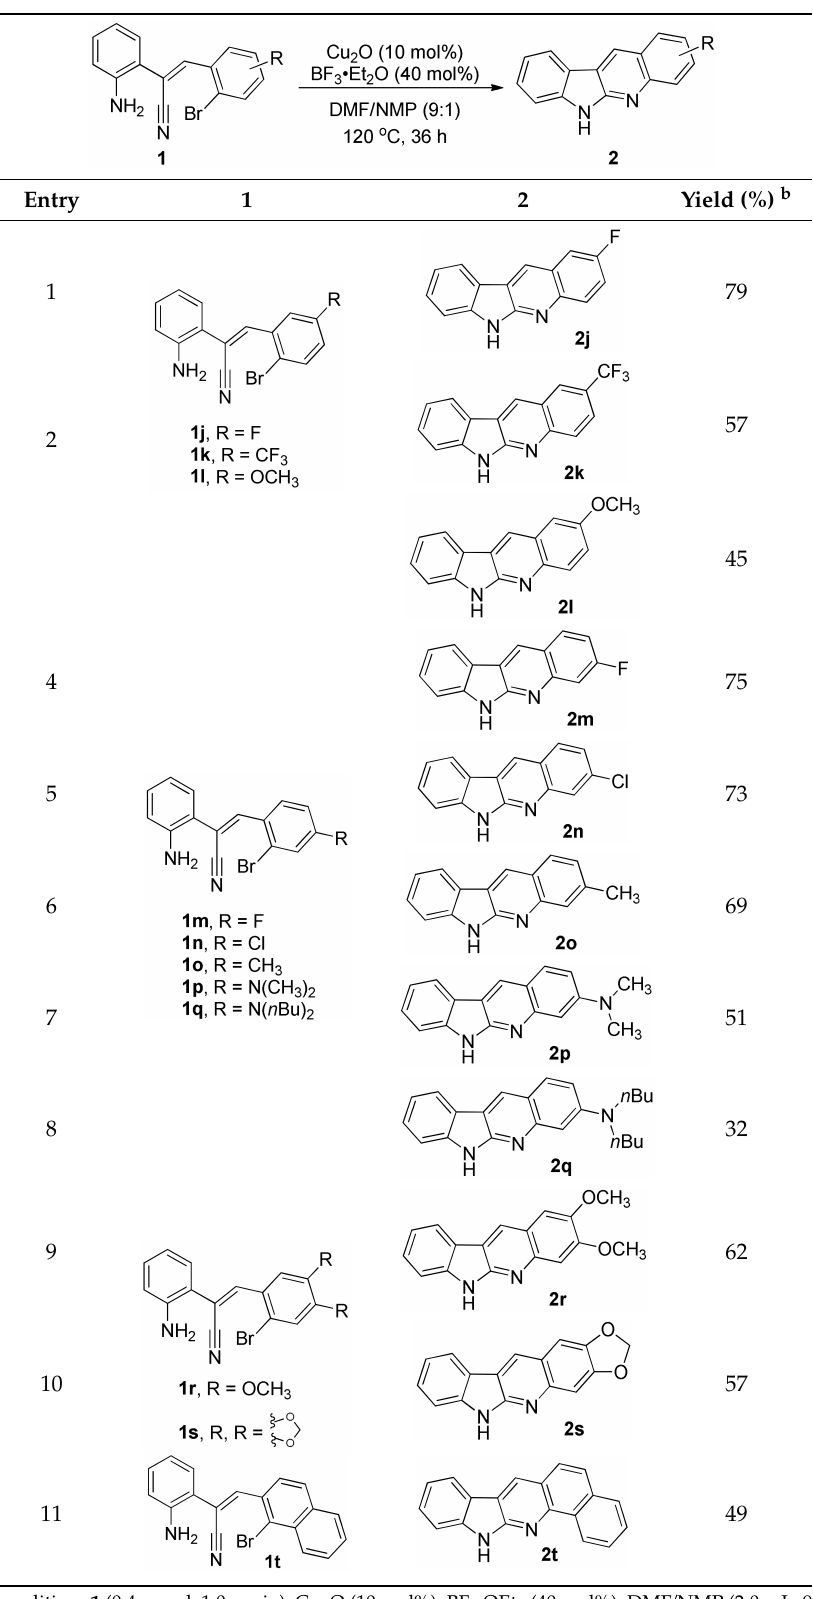
Table 3. Reaction scope a